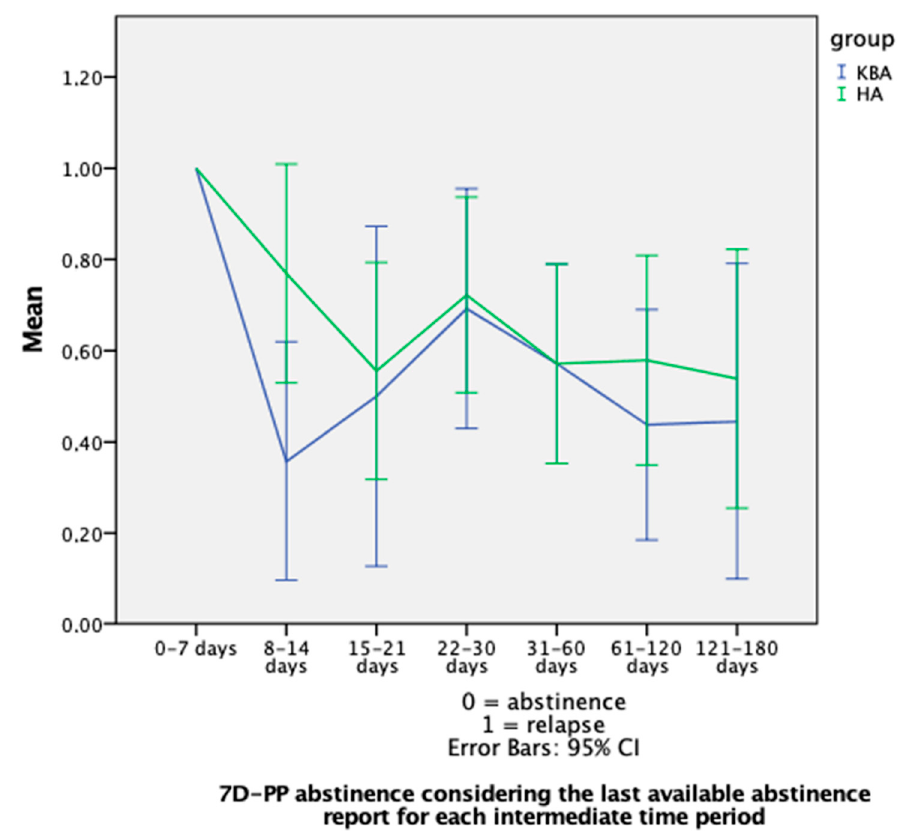
Figure 7. Evolution of the 7D-PP abstinence (based on the last abstinence report) (a lower mean in the figure means more abstinence).